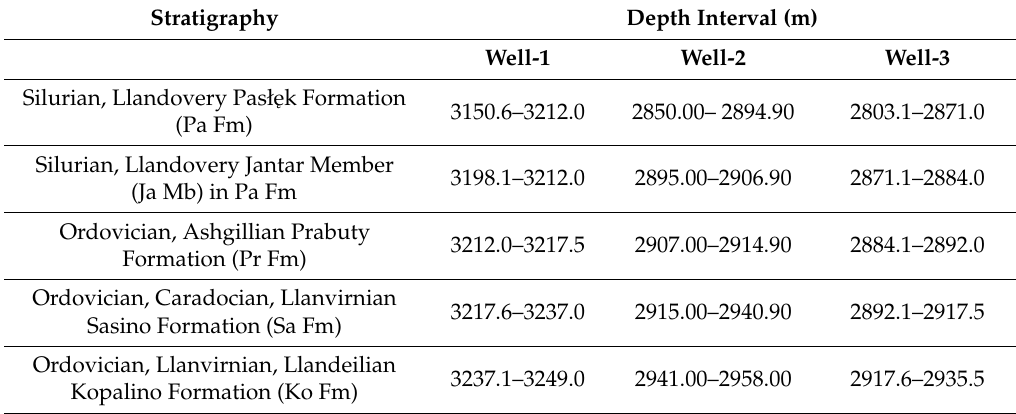
Table 1. Stratigraphy in Well-1, Well-2 and Well-3 (partial information in the depth section between Pa Fm and Ko